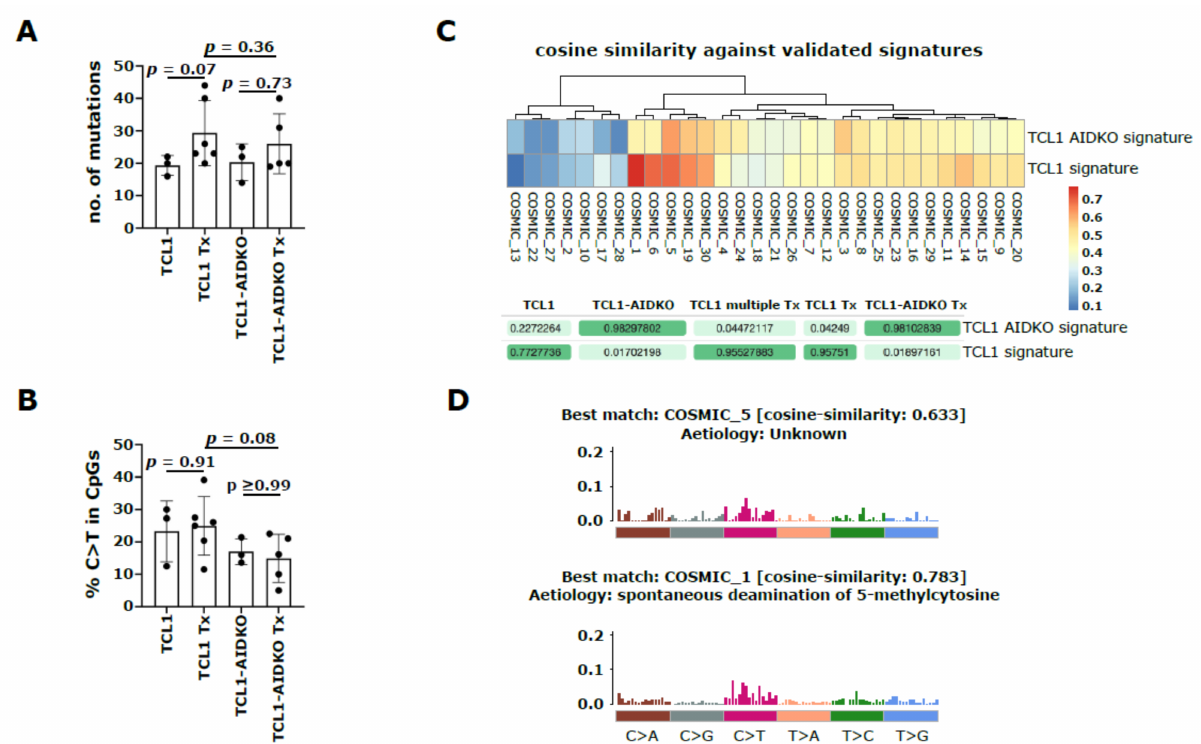
Figure 3. Molecular characteristics and mutational signature of primary (TCL1 and TCL1-AIDKO) and transplanted congenic recipient (TCL1 Tx and TCL1-AIDKO Tx) mice. ( A ) Total number of mutations and ( B ) percentage of C>T transition mutations in CpGs are shown; both two-tailed Mann–Whitney test. ( C ) Heatmap showing the cosine similarities of 2 dominant mutational signatures (TCL1 AIDKO signature and TCL1 signature) found in our cohorts of TCL1 ( n = 7), TCL1-AIDKO ( n = 3), TCL1 Tx ( n = 6), TCL1-AIDKO Tx ( n = 5) and TCL1 multiple Tx ( n = 5) samples against 30 validated COSMIC signatures (top). The contribution of each mouse cohort to TCL1 AIDKO signature and TCL1 signature is